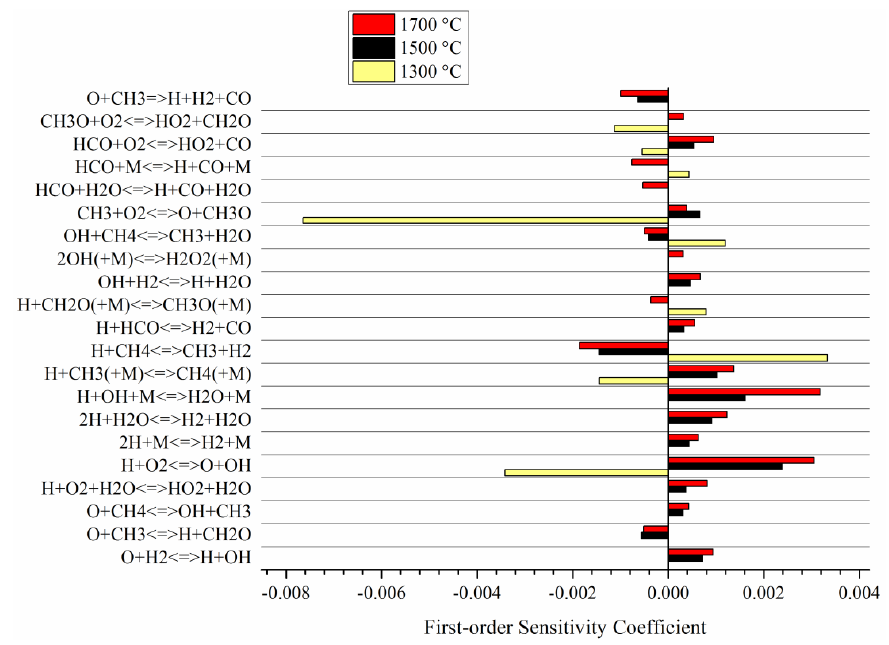
Figure 11. First-order sensitivity analysis for N 2 at different temperatures in air combustion (SR = 0.7).